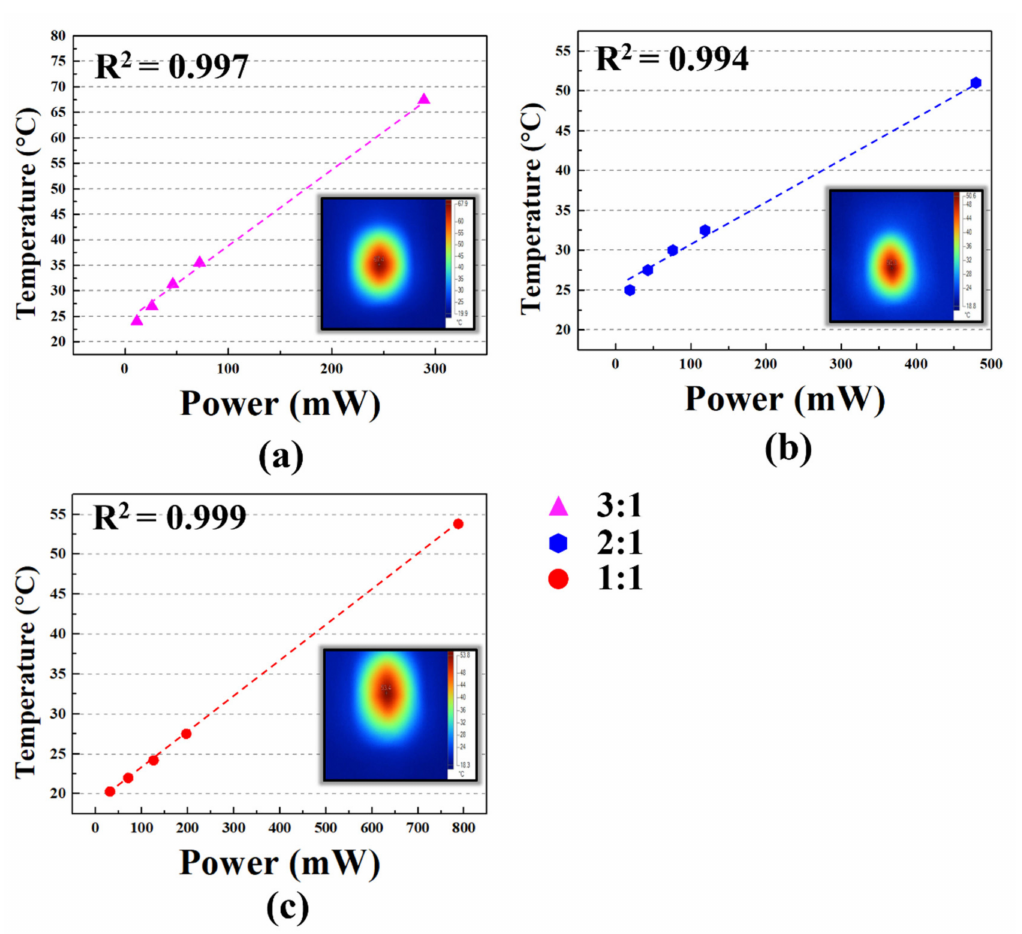
Figure 6. Temperature of microconstruction according to the applied power and infrared camera inset image when applying 10 V to the samples: ( a ) 3:1, ( b ) 2:1, and ( c ) 1:1.